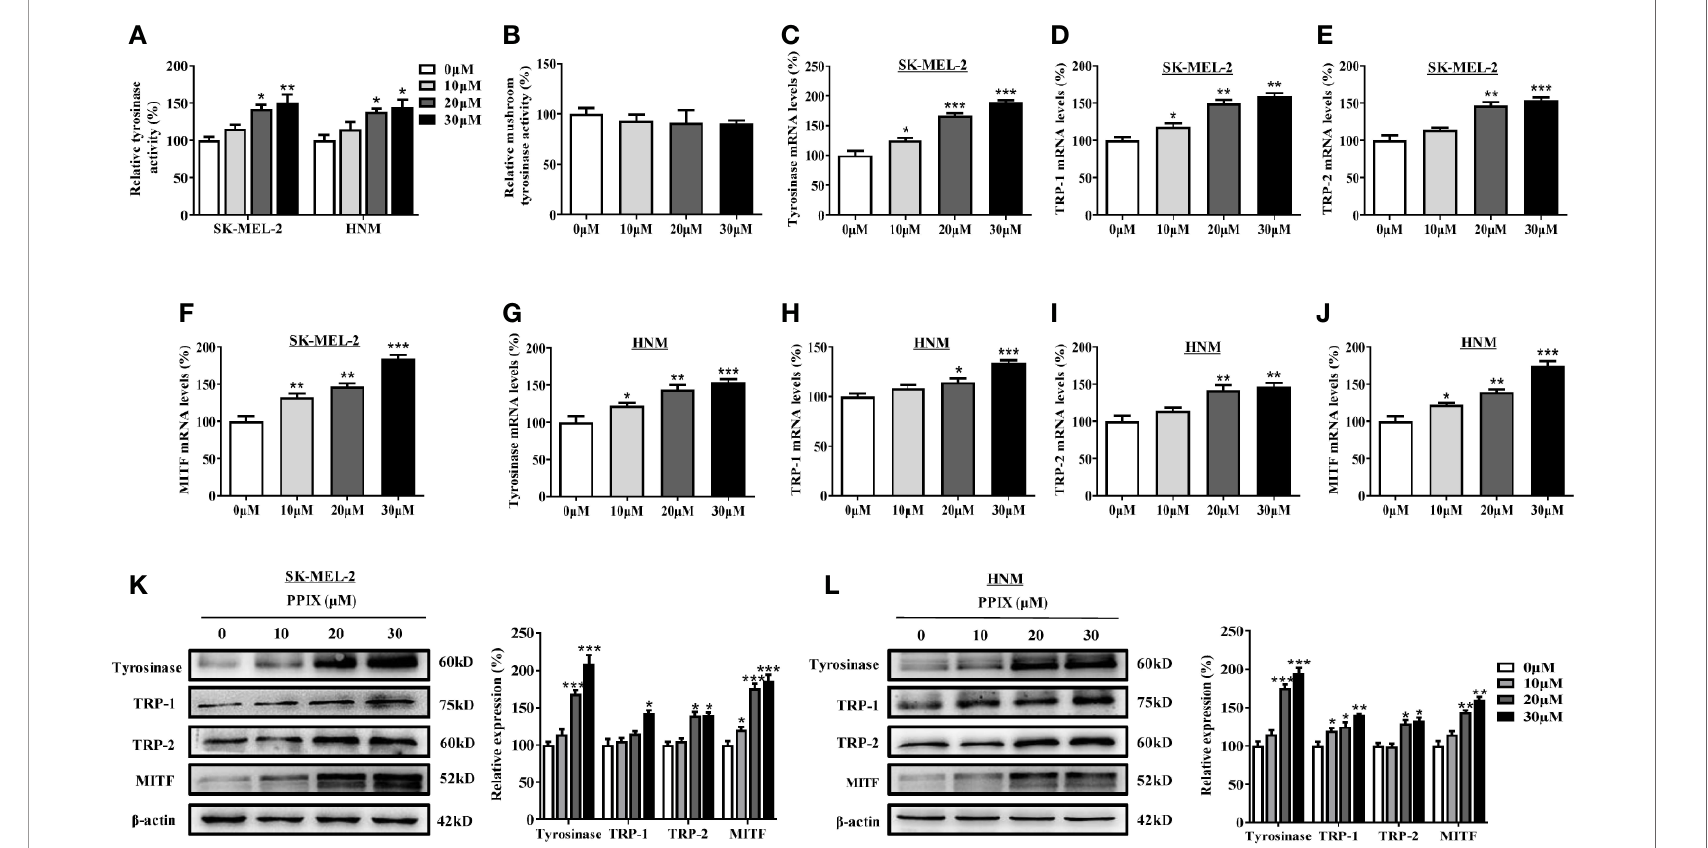
FIGURE 2 | PPIX increased the tyrosinase activity and expression of tyrosinase and MITF. (A) Cellular tyrosinase activity and (B) mushroom tyrosinase activity in a cell-free assay system were measured after PPIX- treated as described in methods. SK-MEL-2 and HNM cells were treated with PPIX (10, 20, and 30 m M) for 12 h, and RT-qPCR was then applied to detect tyrosinase (C , G) , TRP-1 (D , H) , TRP-2 (E , I) , and MITF (F , J) gene expression. (K) SK-MEL-2 cells and (L) HNM were treated with PPIX (10, 20, and 30 m M) for 48 h, and western blot was then applied to detect the protein levels of tyrosinase, TRP-1, TRP-2, and MITF. Data are expressed as the mean ± SEM (n = 3). *p < 0.05, **p < 0.01, ***p < 0.001 versus non-treated